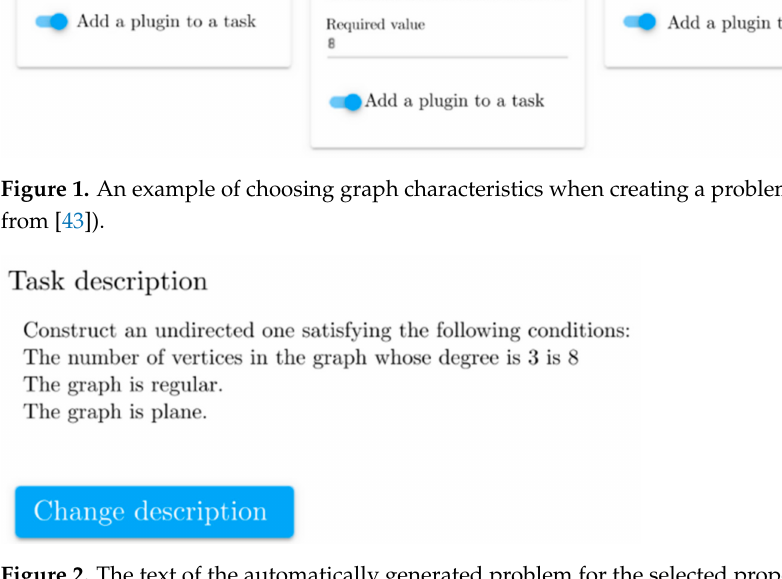
Figure 2. The text of the automatically generated problem for the selected properties of the solution (the figure is taken from [43]).